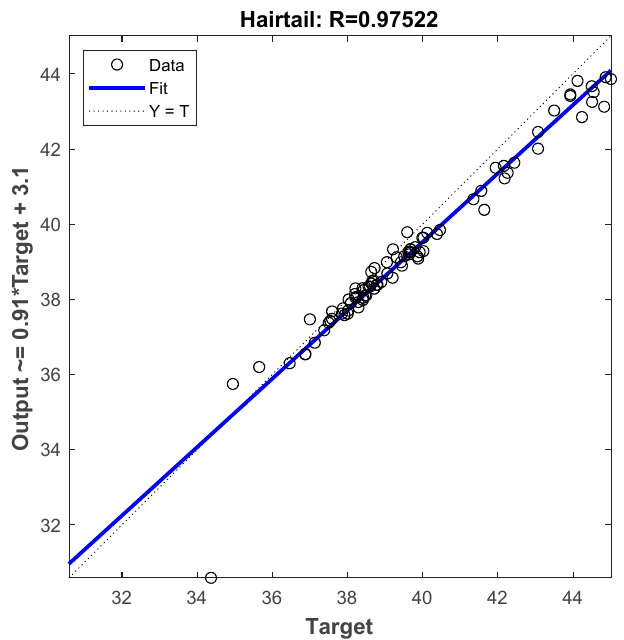
Figure 11. Data regression image of each aquatic product price test set.